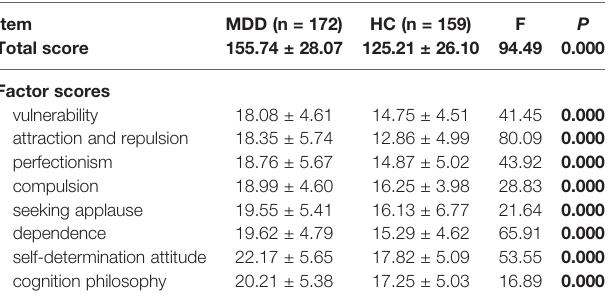
TABLE 2 | Comparison of the C-DAS-A total and factor scores in the MDD and HC groups. Item